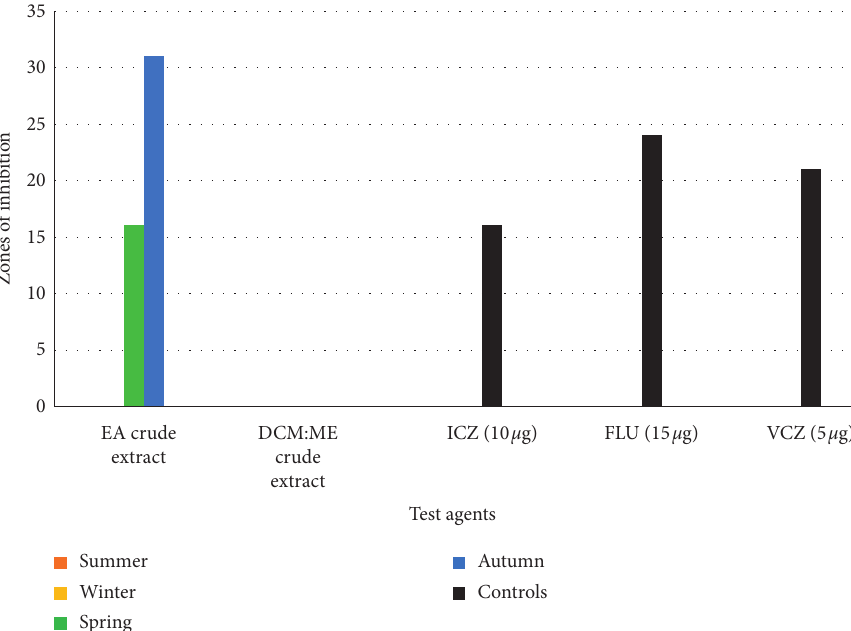
Figure 5: Antifungal activity of ethyl acetate (EA) and dichloromethane: methanol (DCM :ME) crude extracts against A. fumigatus